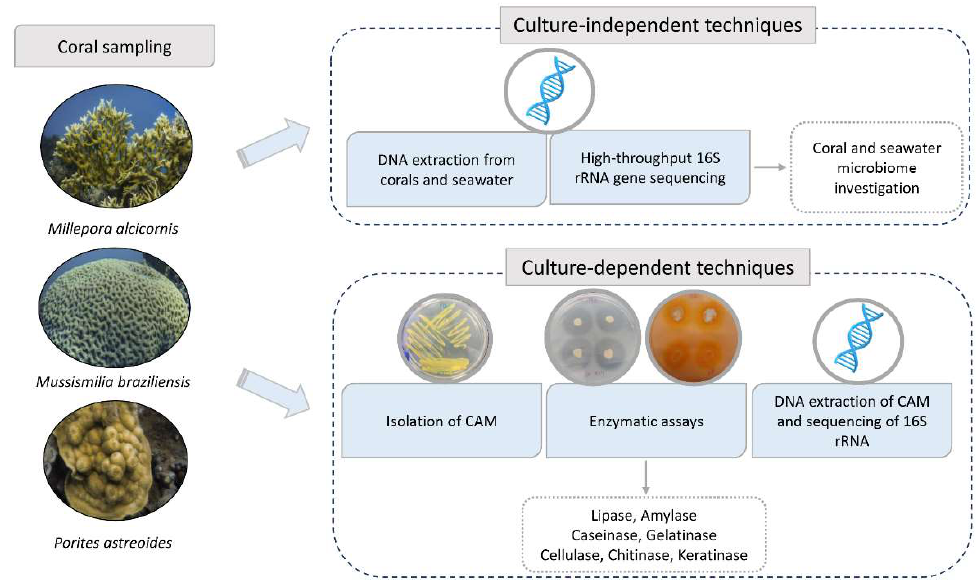
Figure 1. Flowchart summarizing the experimental activities. Coral and seawater samples had their DNA extracted for culture-independent analysis. Bacterial isolates were obtained from samples of the corals Millepora alcicornis , Mussismilia braziliensis , and Porites astreoides (Ma, Mb and P) and screened for enzymes with industrial interest and identified by sequencing of rRNA 16S. (Coral photos credit: Augusto